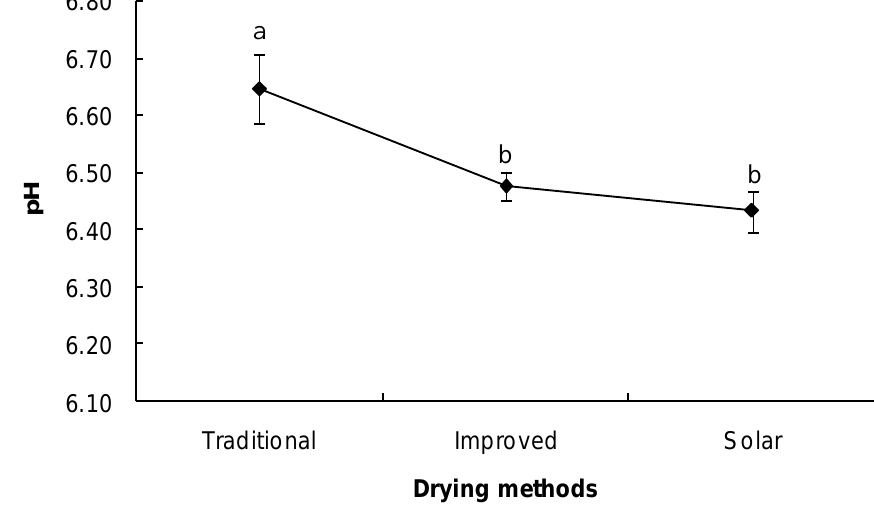
Figure 2. Changes in pH value of H. molitrix in various drying methods.